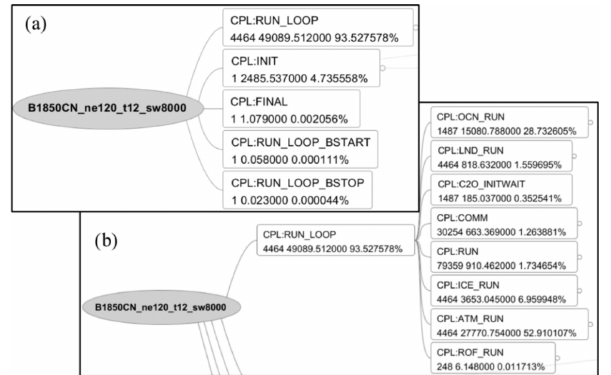
Figure 3. An example of tracking computing hotspots in ma- jor components of the 10km ocean + 25km atmosphere high- resolution CESM for the pre-industrial control experiment with the 1850 fixed-year radiative forcing using 8000 core groups on the Sunway machine (B1850CN_ne120_t12_sw8000) for 1-month integration; (a) the total number of calls (in integer, 4464 calls of RUN_LOOP in this experiment, for instance), the total sec- onds of computing time (in real, 49089.512s for the 4464 calls of RUN_LOOP, for instance) and projected percentage (93.528% for the 4464 calls of RUN_LOOP, for instance) in five items of the main driver; (b) further partitions of the 93.528% RUN_LOOP in eight model